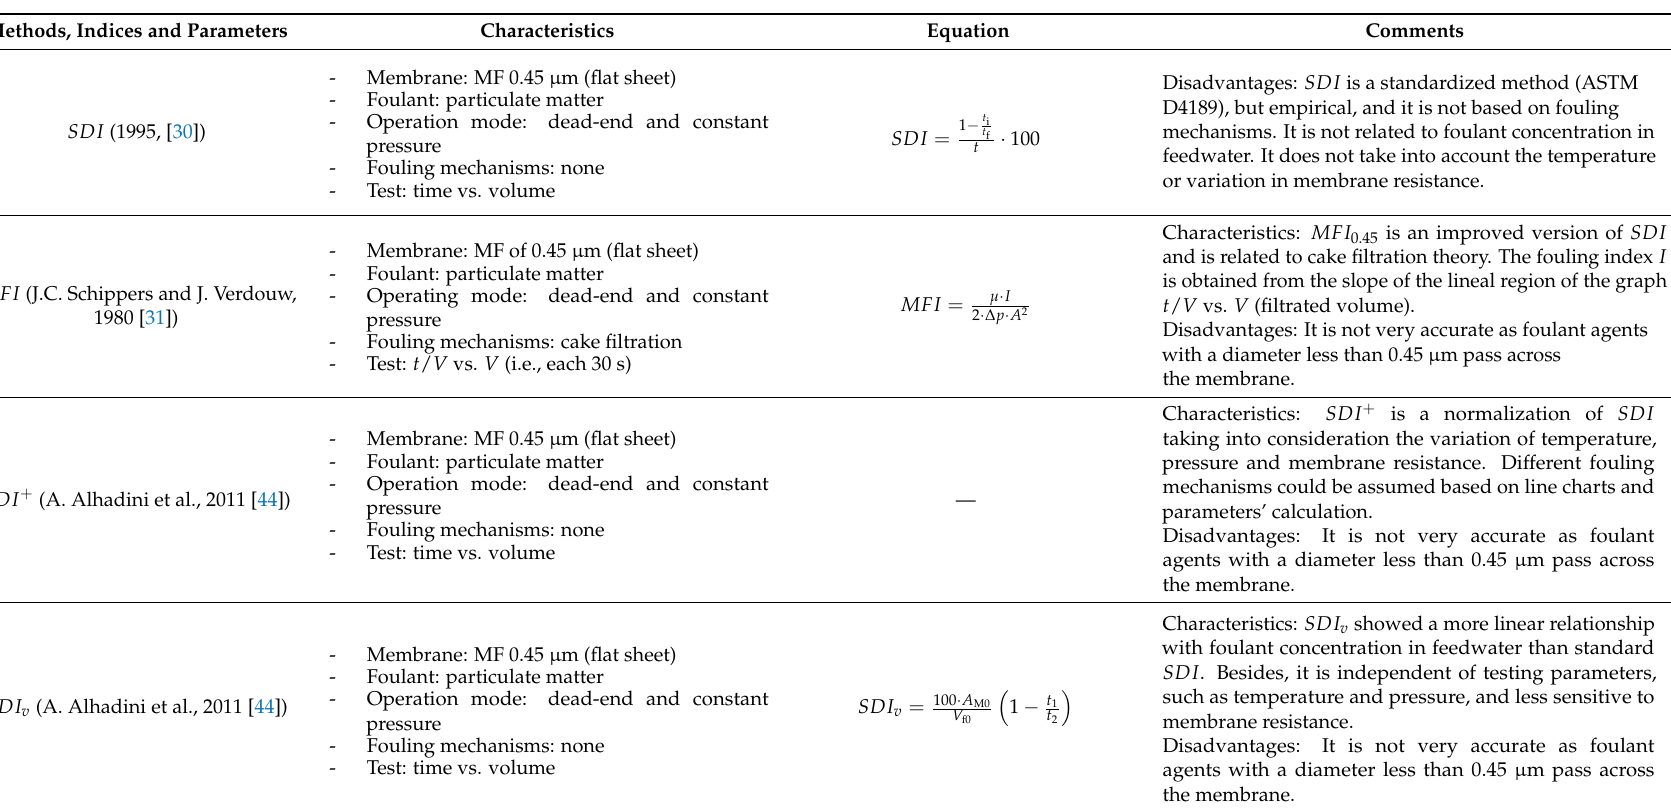
Table 1. Summary of various methods, indices and parameters used in fouling evaluation (adapted from [38,45,56]). SDI , Silt Density Index; MF, Microfiltration; MFI , Modified Fouling Index; UF, Ultrafiltration; CFS , Cross-Flow Sampler; RO, Reverse Osmosis; MMAS, Multiple Membrane Array System; DFI , Dimensionless Fouling Index; CEOP, Cake-Enhanced Osmotic